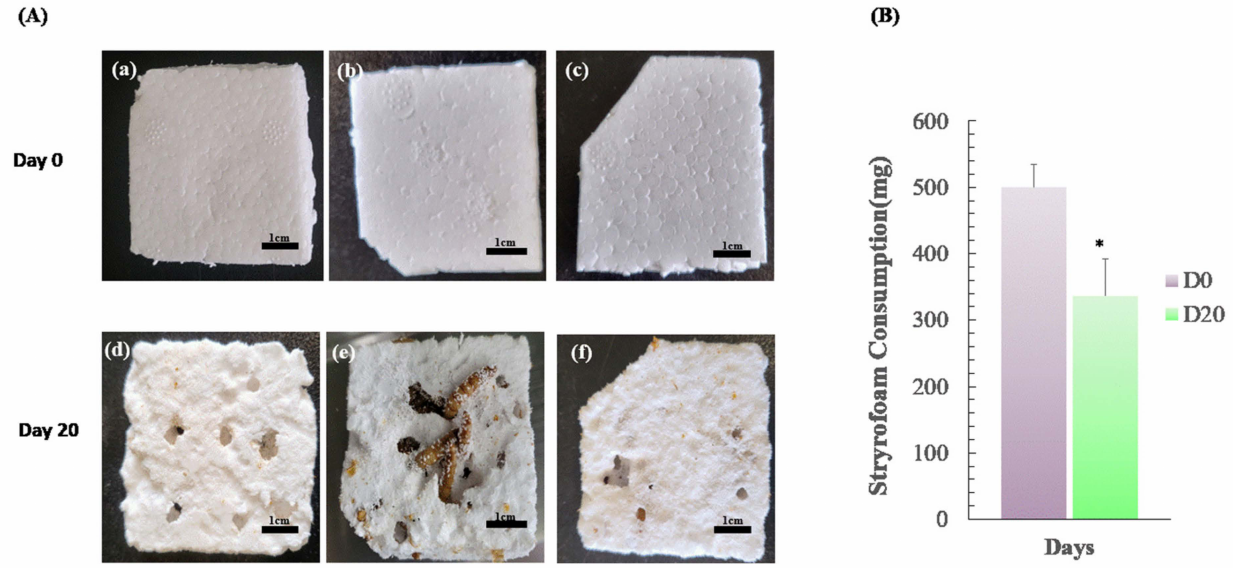
Figure 1. The ability of mealworms to break down Styrofoam. ( A ) Mealworms show changes before and after eating them Styrofoam. In a group of 50 mealworms, only Styrofoam was provided as feed for 20 days (a–c), and the mealworms were observed to decompose it (d–f). ( B ) After 20 days, the mealworms were isolated and the weight of the Styrofoam was compared with the first day (Day 0). All data are expressed as means ± SEM for triplicate measurements. The significant differences are indicated by asterisks (* p <